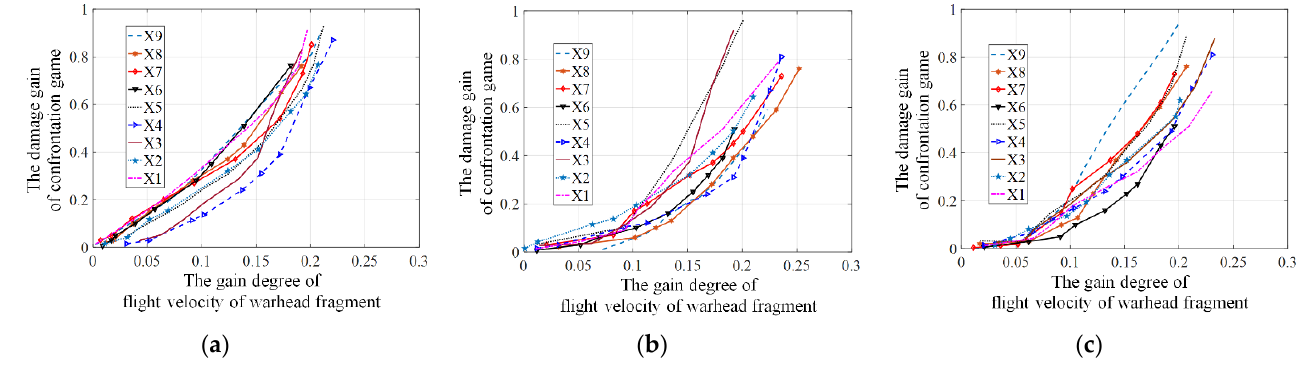
Figure 5. The damage gain of the confrontation game under the different flight velocities of the warhead fragment: ( a ) The damage gain of the confrontation game when the flight velocity of the warhead fragment is 1500 m/s; ( b ) The damage gain of the confrontation game when the flight velocity of the warhead fragment is 2000 m/s; ( c ) The damage gain of the confrontation game when the flight velocity of the warhead fragment is 2500 m/s.